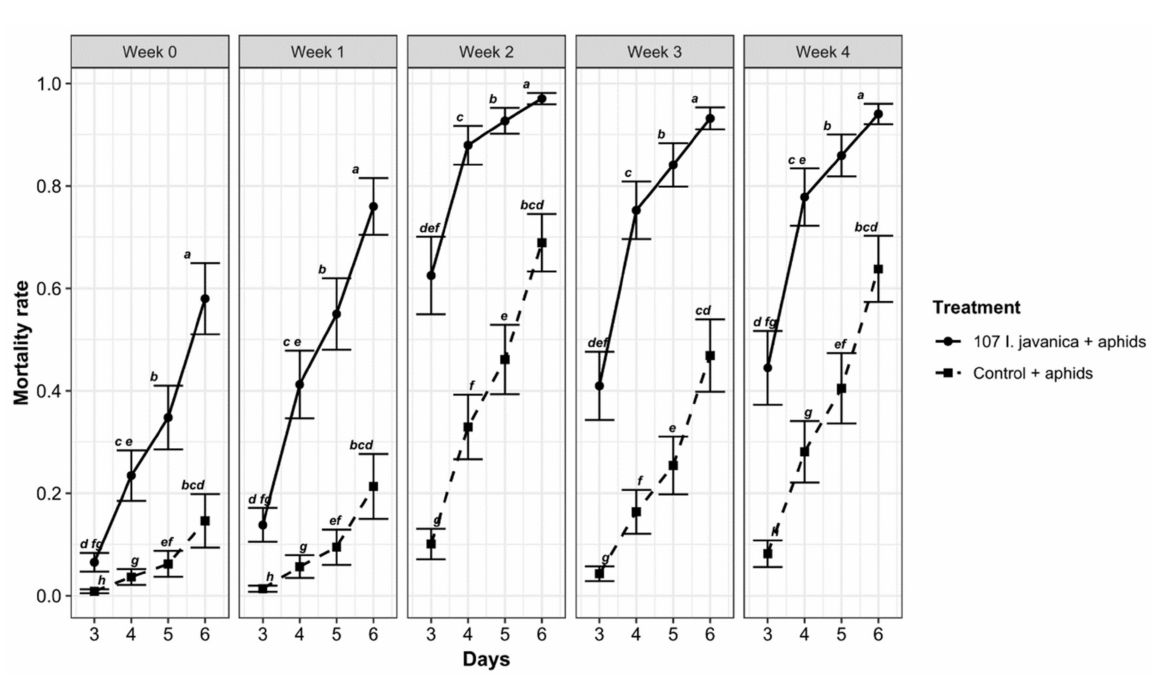
Figure 4. Change in mortality rate across weeks of the experiment for each treatment. Mortality rate: percent of dead aphids after spraying. Days: number of days after spraying. Means with the same letters (a, b, c, d, e, f, g, h) do not differ